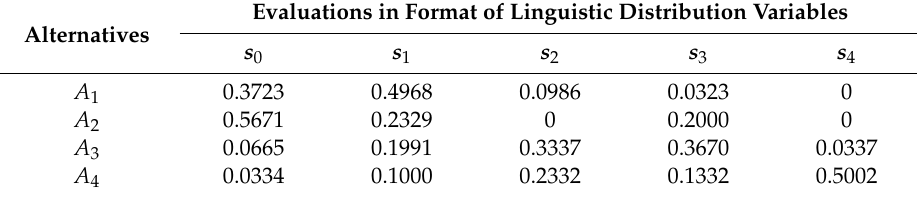
Table 4. The linguistic distribution evaluations on criterion C 4 .